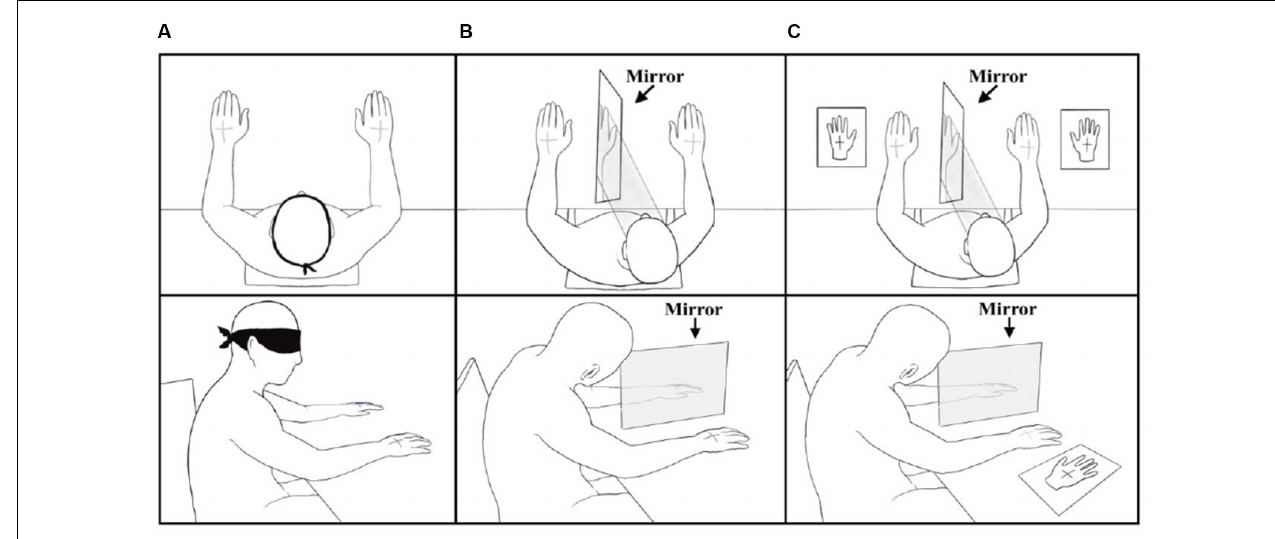
FIGURE 2 | Top view and side view of the Baseline Condition (A) , Mirror Condition-Pointing (B) , and Mirror Condition-Silhouette (C) .